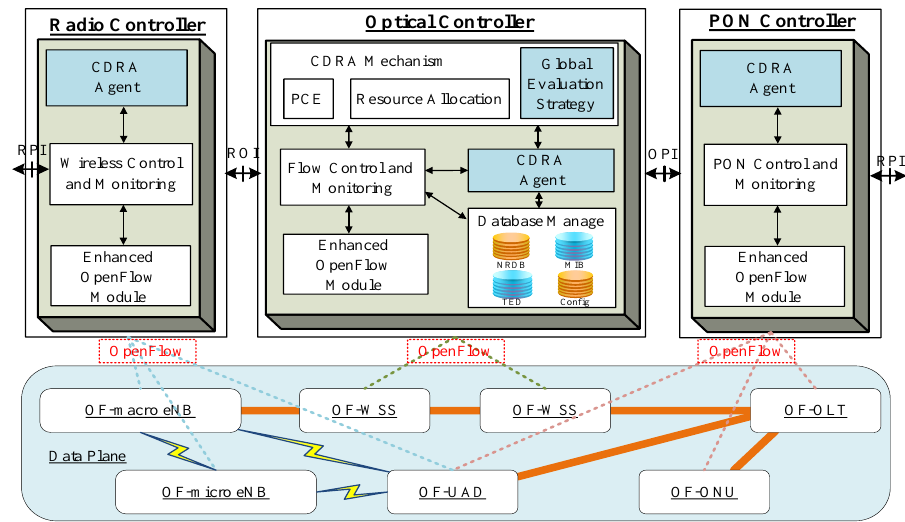
Figure 3. Unified control architecture in optical access network.